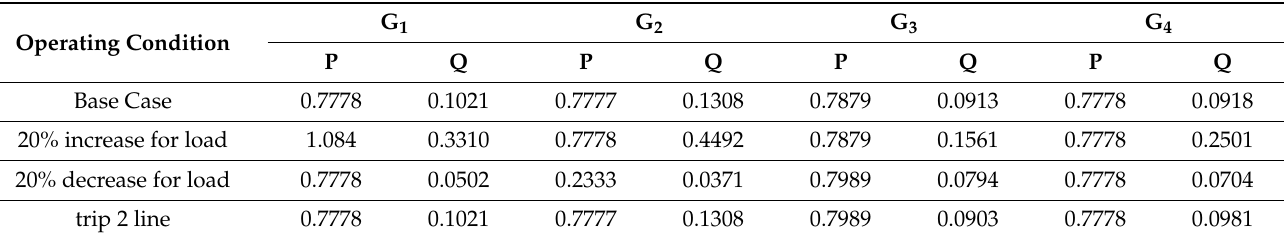
Table 5. The numerical comparison between the proposed